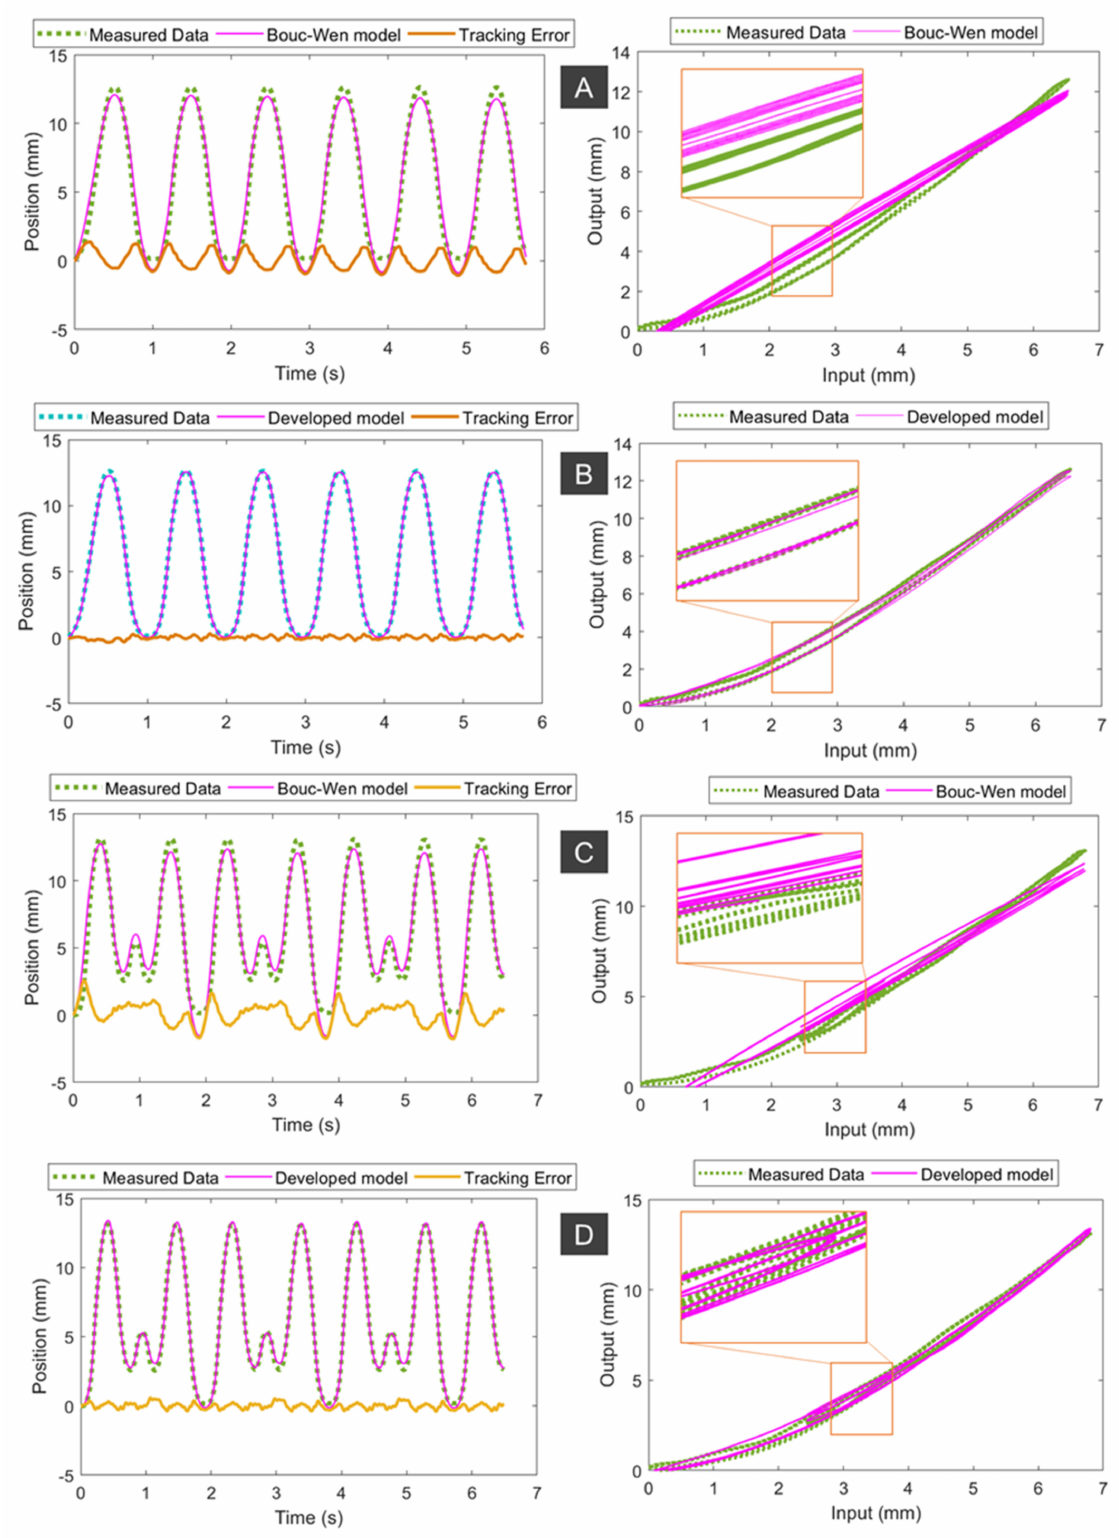
Figure 5. Comparison between the hysteresis models and experimental data using 1 Hz sine wave input signal ( A , B ) and combined frequency of 1 Hz and 1.5 Hz ( C , D ). ( A , C ) The symmetric Bouc–Wen model. ( B , D ) The developed asymmetric hysteresis model given by Equations (1) and